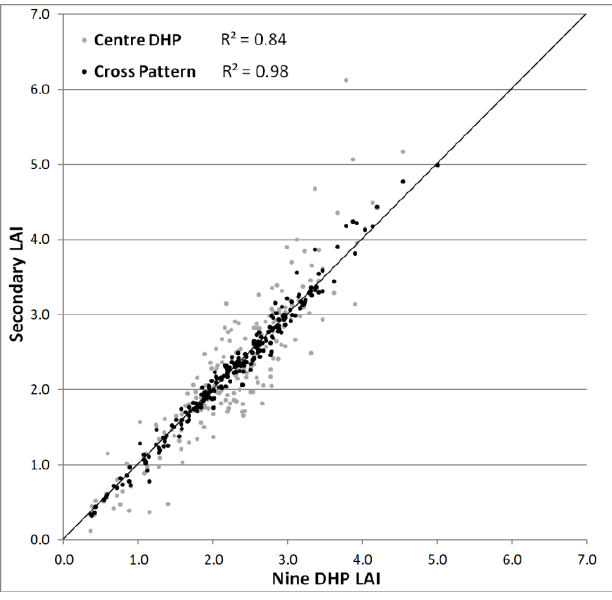
Figure 10. Comparison of plot LAI between the nine sample DHP average (x-axis); the